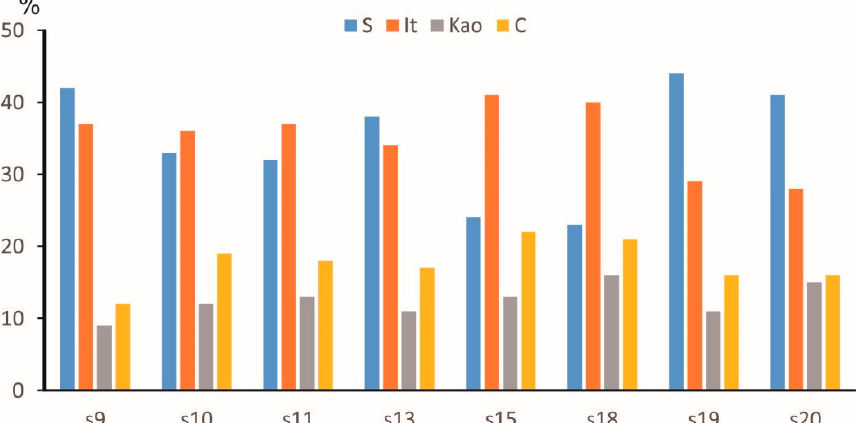
Figure 3. Clay mineral composition of Xisha Uplift surface sediments (<2 microns). S: smectite, It: illite, Kao: kaolinite, C: chlorite.